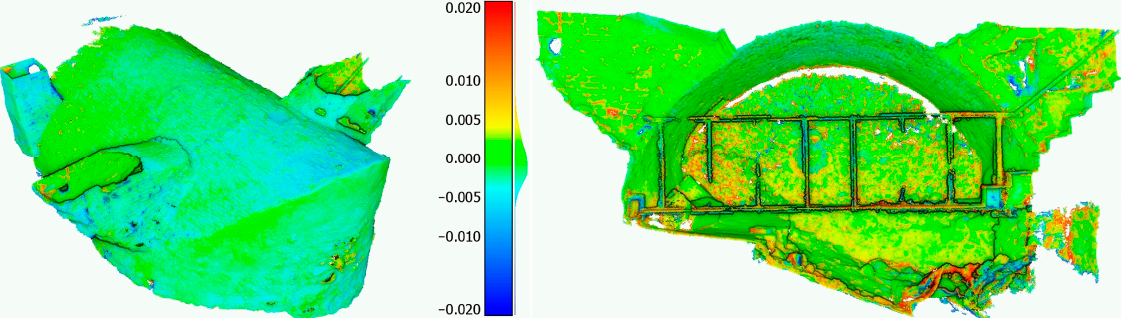
Figure 12. Deviations in the comparison of TLS and photogrammetry with all images active (TLS vs. A) in the ossuary (external view on the left , cross-section on the right ). 4.2. Photogrammetric Variants B, C, and D vs. the Reference Photogrammetric Variant